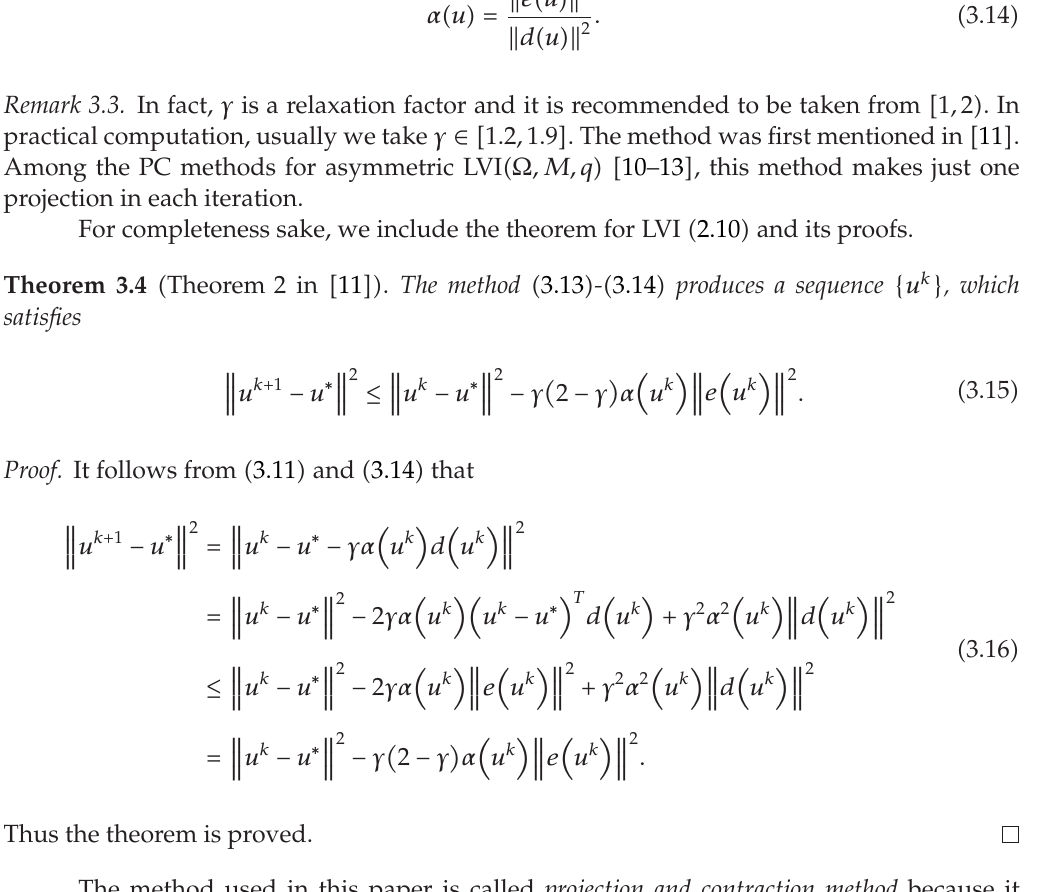
Algorithm 3.2 (cid:2) Projection and Contraction Method for LVI Problem (cid:2) 2.10 (cid:3)(cid:3) . Given u 0 ∈ Ω .